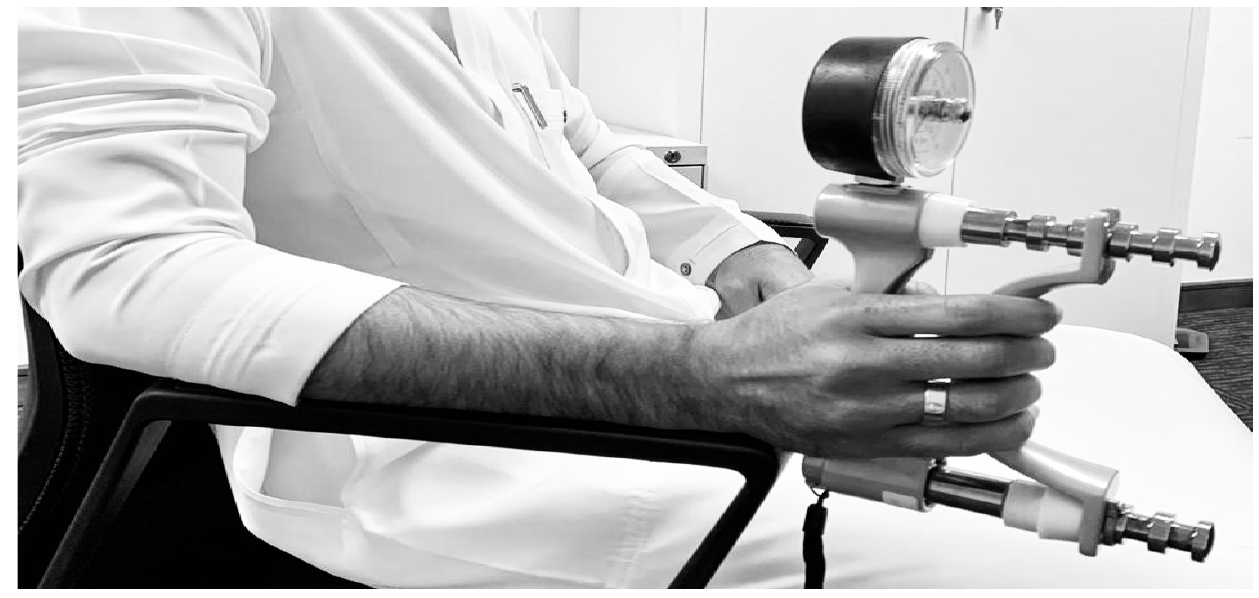
Figure 3. Handgrip strength measurement with handheld Jammer Dynamometer.